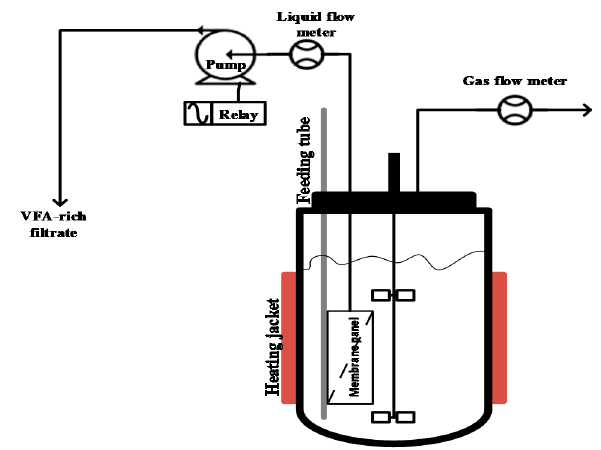
Figure 3. Schematic diagram of the semi-continuous set-up.